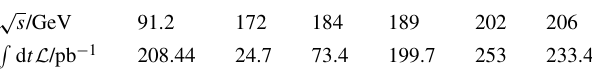
(cid:8) Table 2 Luminosity scaling factors c bb and c recoil derived via com- d t L , at the dif- √ s , that are used for parison with the S 95 results for the LEP 1 (91.2 GeV) and LEP 2 ( > 91 . 2 GeV) energy stages from the LEP combination for the analysis using the φ → b ¯ b final state and from the OPAL results for the